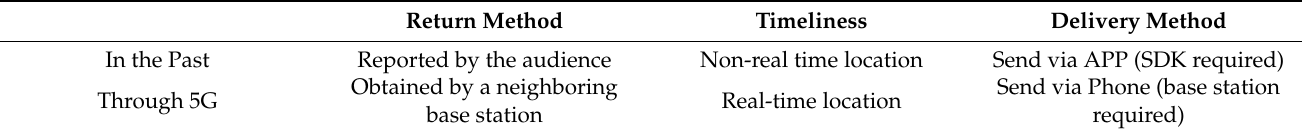
Table 2. Comparison of audience data collection methods.